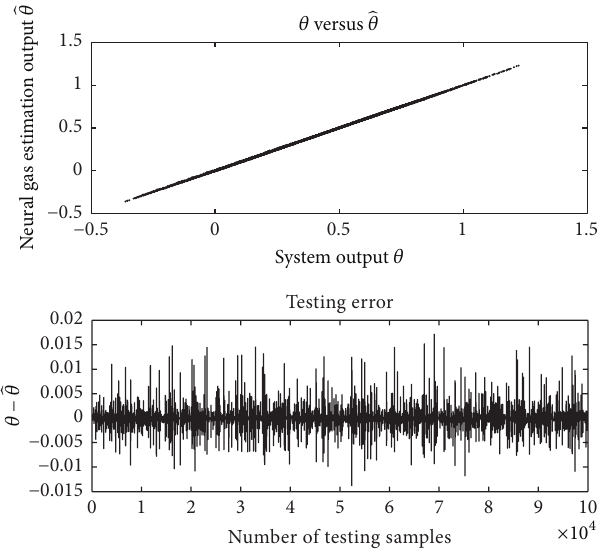
Figure 3: Results for testing data using 𝑛 = 4